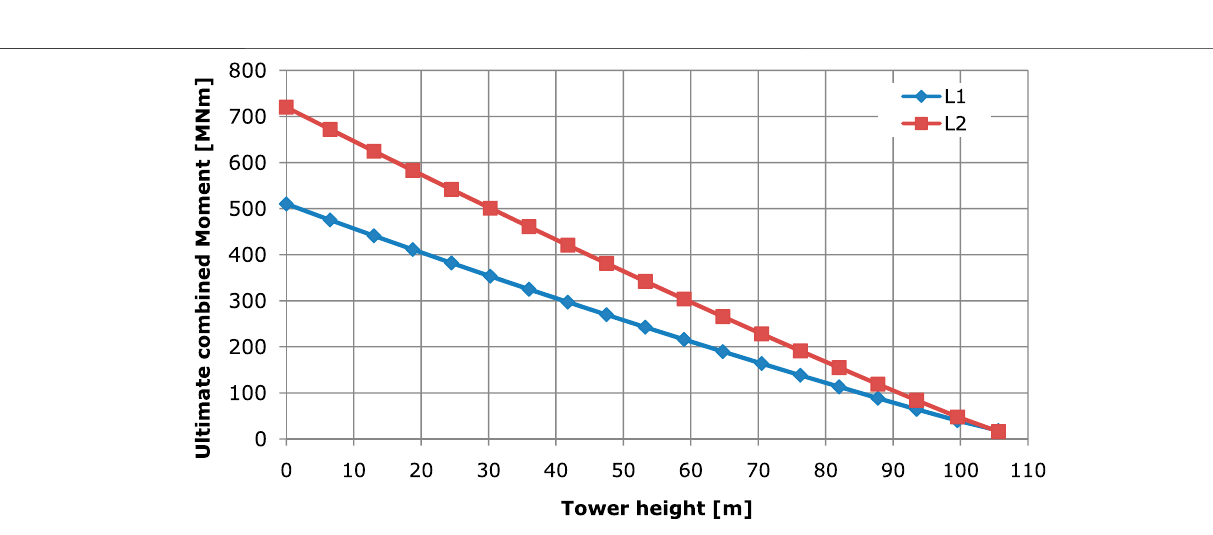
FIGURE 13 | Comparison of ultimate tower base combined moment and mooring line tension at fairleads at L1 and L2 locations for the DLCs performed. The relative percentage difference with respect to L1 is also provided above the bars.